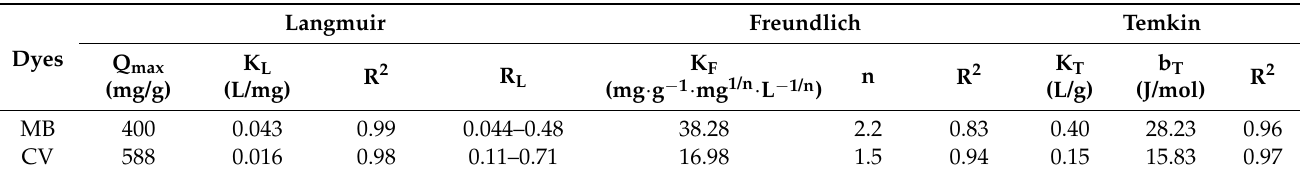
Figure 5. ( a ) The effect of initial concentration on the performance for the adsorption of MB and CV by MT. Adsorption isotherms for the adsorption of MB and CV by MT: ( b ) Langmuir model, Freundlich model, and ( c ) Temkin model. Table 3. Adsorption isotherm parameters for the adsorption of MB and CV by MT.